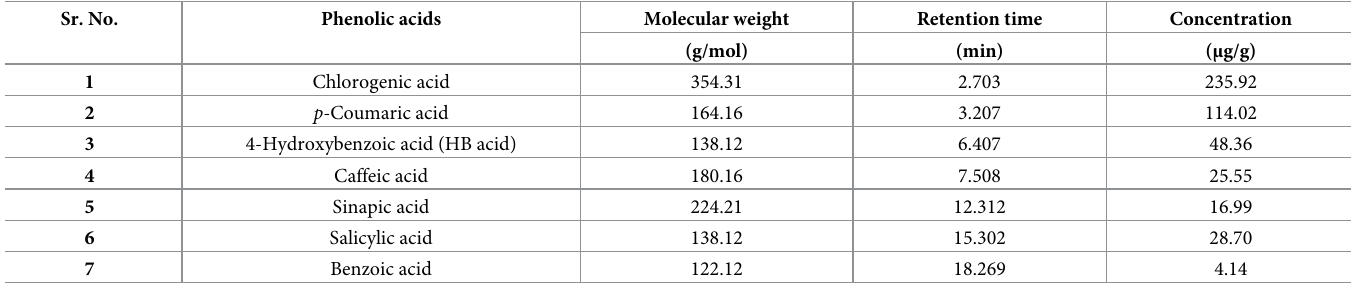
Table 1. HPLC analysis of phenolics / organic acids in cell free supernatant (CFS) of Loig . coryniformis BCH-4. Sr.